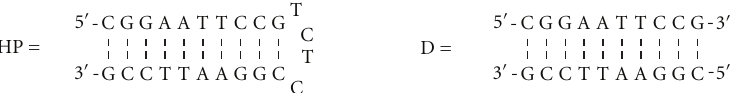
Figure 1: Schematic presentation of the model oligonucleotides: hairpin (HP), duplex